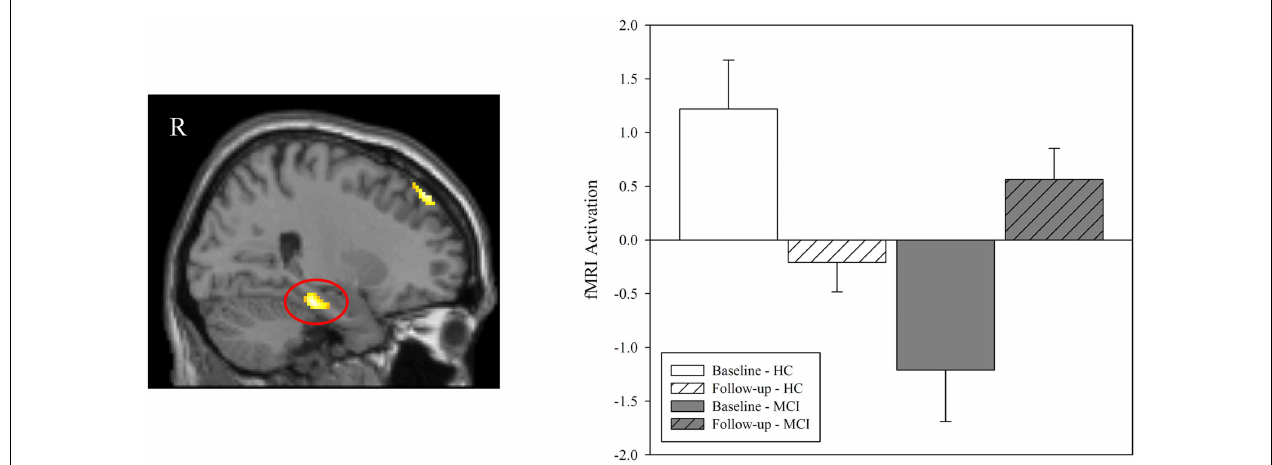
FIGURE 3 | Effect of diagnostic group and donepezil treatment on medial temporal activation during episodic encoding relative to episodic recognition .Values for fMRI activation were extracted from a region of interest (ROI) in the right medial temporal lobe (right hippocampus and parahippocampal gyrus) that was observed to be significant in the voxel-wise analysis of the interaction of diagnostic group-by-time (left panel; also see Figure 2C ). Group means demonstrated significant effects of diagnostic group and time. Similar to the results seen in the voxel-wise